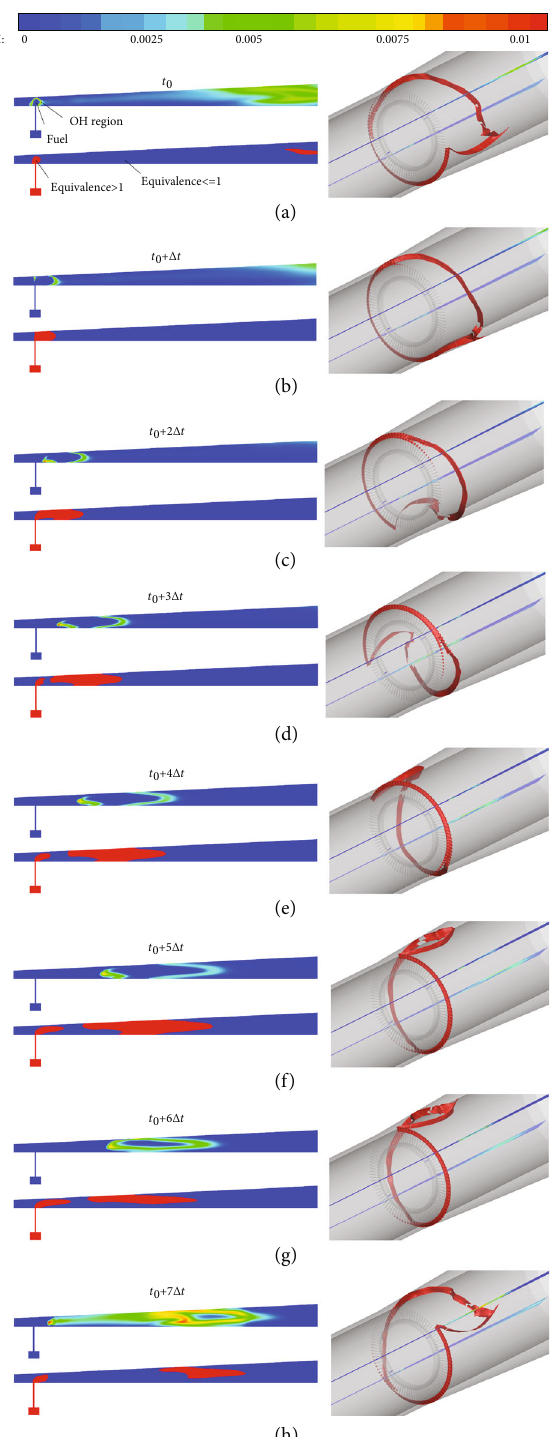
Figure 10: OH contours of case 1 at di ff erent times. The time interval is Δ t = 19 : 1 μ s . Local slices are on the left of (a) – (h) (up: OH contour, down: equivalence ratio contour), and 3D views with a slice pressure isosurface of P = 0 : 3 MPa are on the right of (a) –